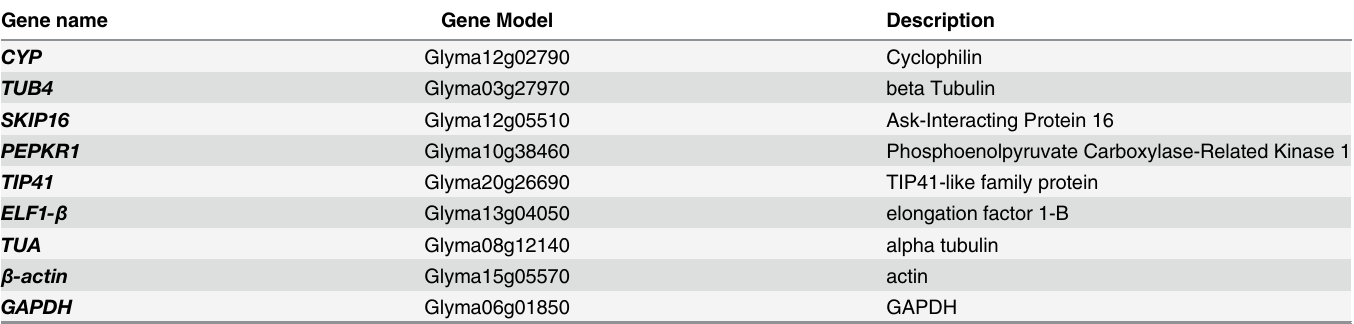
Table 1. Commonly used RT-qPCR reference genes from soybean, according to Hu and colleagues